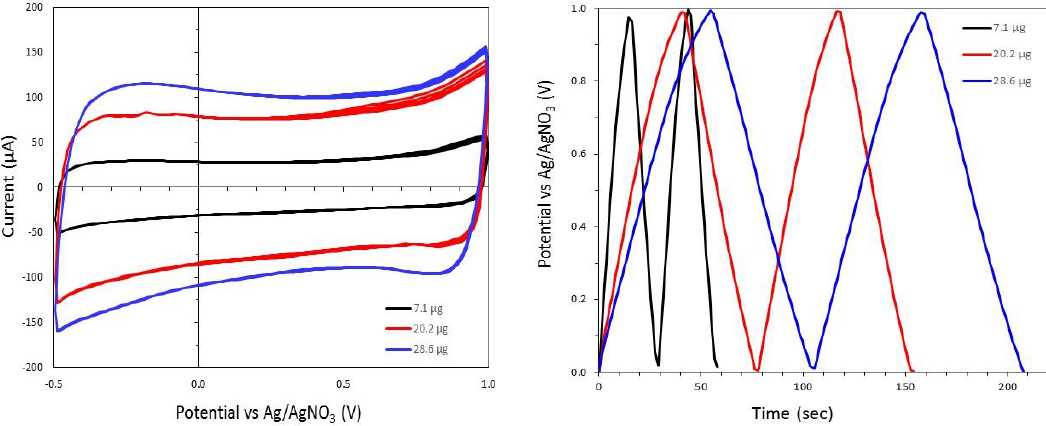
Figure 15. Cyclic voltammograms ( left ) and charge–discharge measurements ( right ) of three different pristine HiPco SWCNT electrodes. Rectangular CV and triangular GCD indicative of pure EDL capacitance.